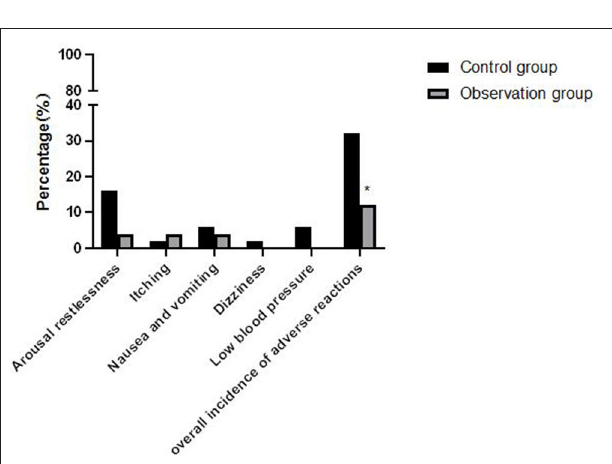
FIGURE 4 | Comparison of the incidence of adverse reactions between the two groups of patients. Compared with control group, * P <